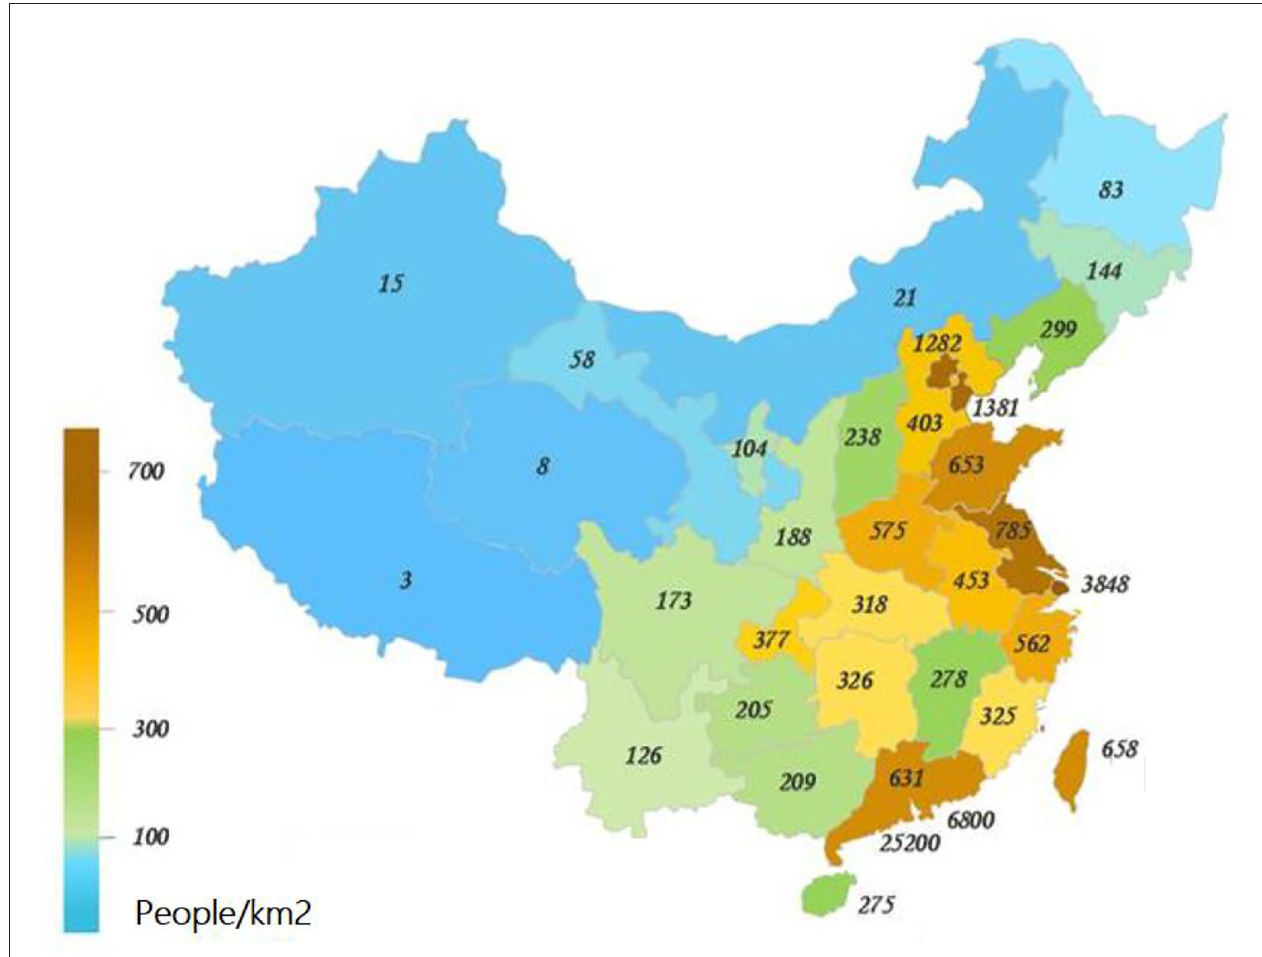
FIGURE 2 | Population density of 34 provinces and cities in China in